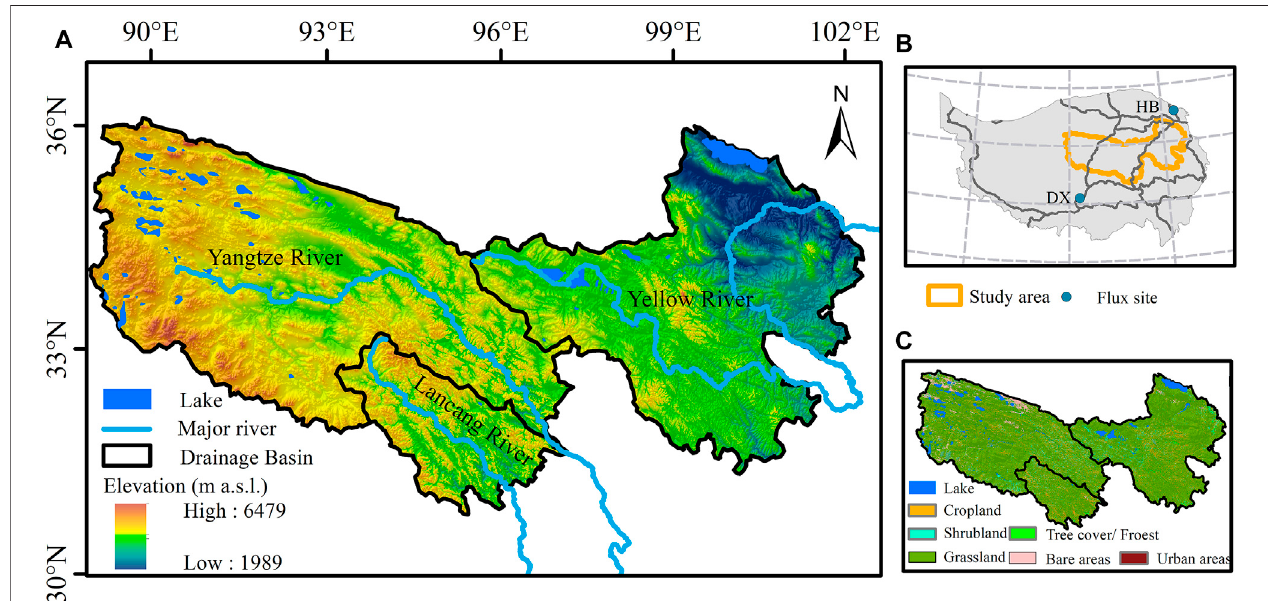
FIGURE 1 | Topography of the Three-River Headwaters Region (TRHR) (A) , its location on the Qinghai-Tibet Plateau (B) , and the distribution of land cover within this region (C) . DX: the Damxung fl ux site; HB: the Haibei fl ux site.